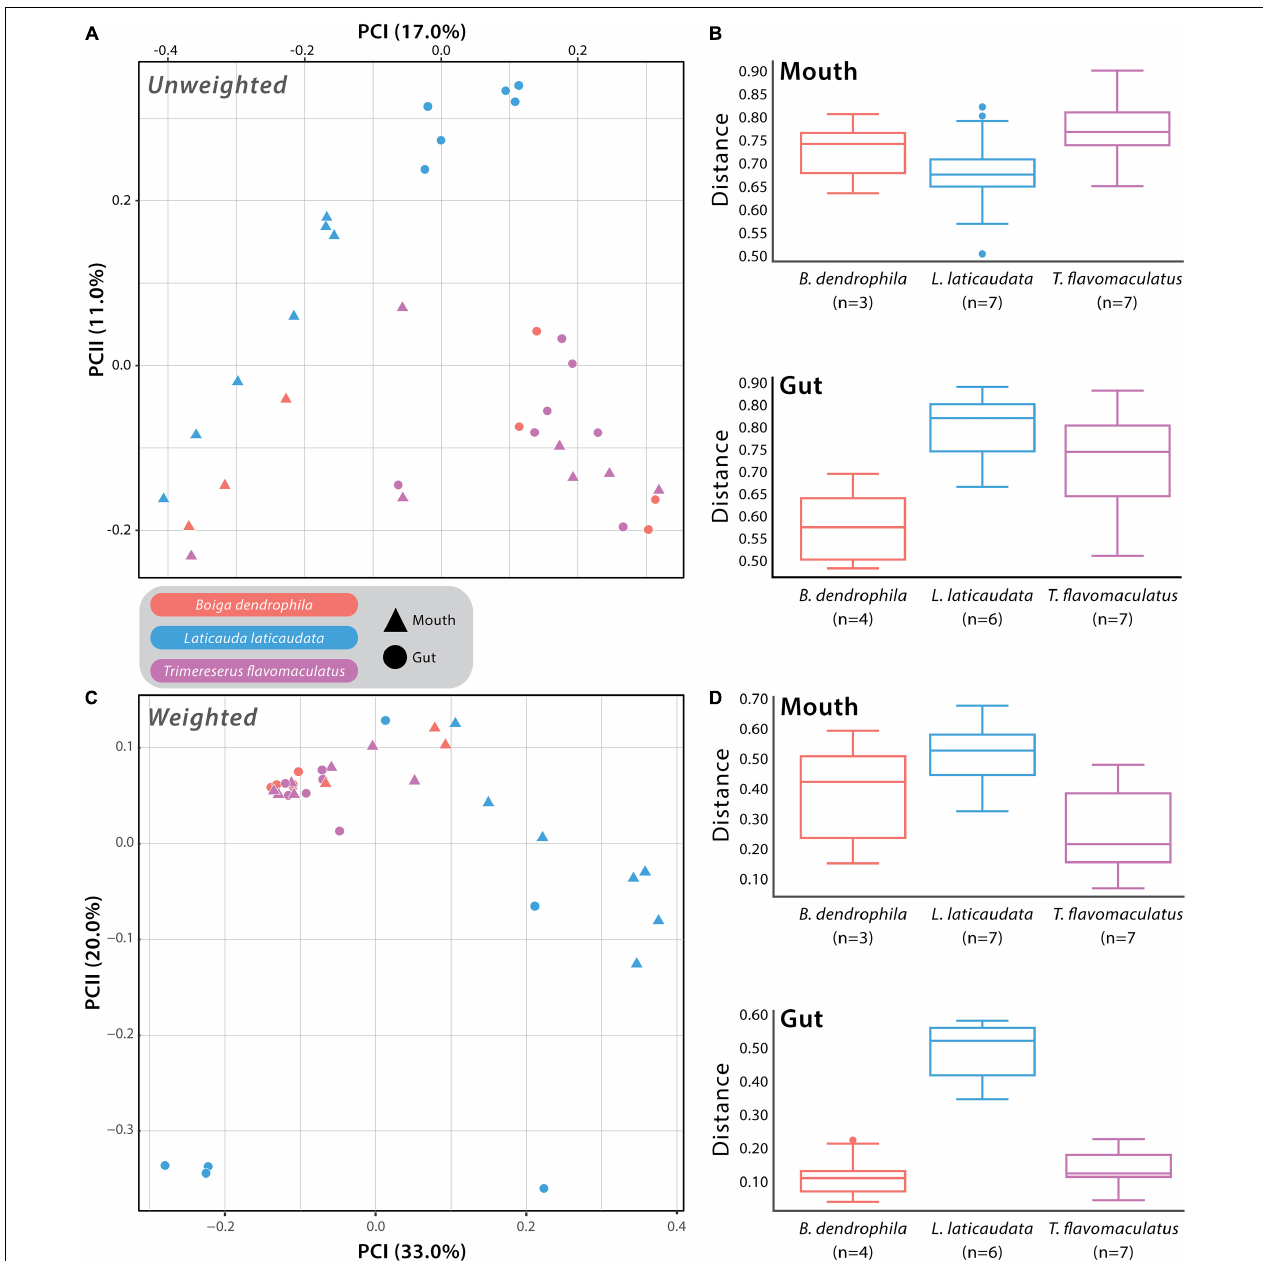
FIGURE 3 | Beta diversity comparisons based on Unweighted- and Weighted-Unifrac distances. (A) Principal Coordinates Analysis (PCoA) of all samples with point shape indicating different body sites: triangle = mouth sample and circle = gut sample, and point color indicating the different host species: red = Boiga dendrophila , blue = Laticauda laticaudata , and purple = Trimeresurus flavomaculatus . (B) The associated boxplots generated by the PERMANOVA comparing mouth and gut microbiome samples from each host species. (C) PCoA of all samples based on Weighted-Unifrac distances with the same point shapes and colors as the Unweighted-Unifrac PCoA (D) The associated mouth and gut boxplots generated by the PERMANOVA. Each point represents a single swab. For clarification on sample sizes (n) pre- and post-rarefaction, please see Supplementary Table 1